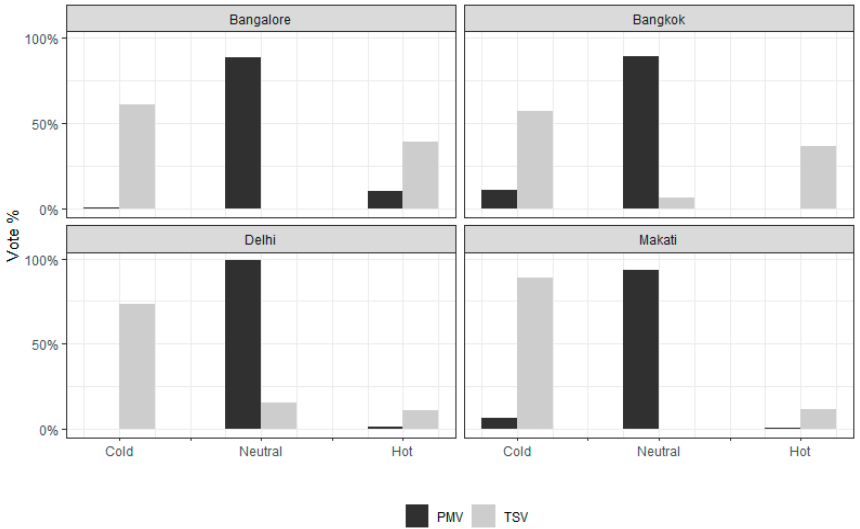
Figure 3. TSV and PMV distribution of building occupant data in the ASHRAE global database for Bangalore, Bangkok, Delhi, and Makati indicating cold thermal sensation (below − 1), hot thermal sensation (above +1), and neutral thermal sensation represented by the remaining votes on the ASHRAE seven-point thermal scale.